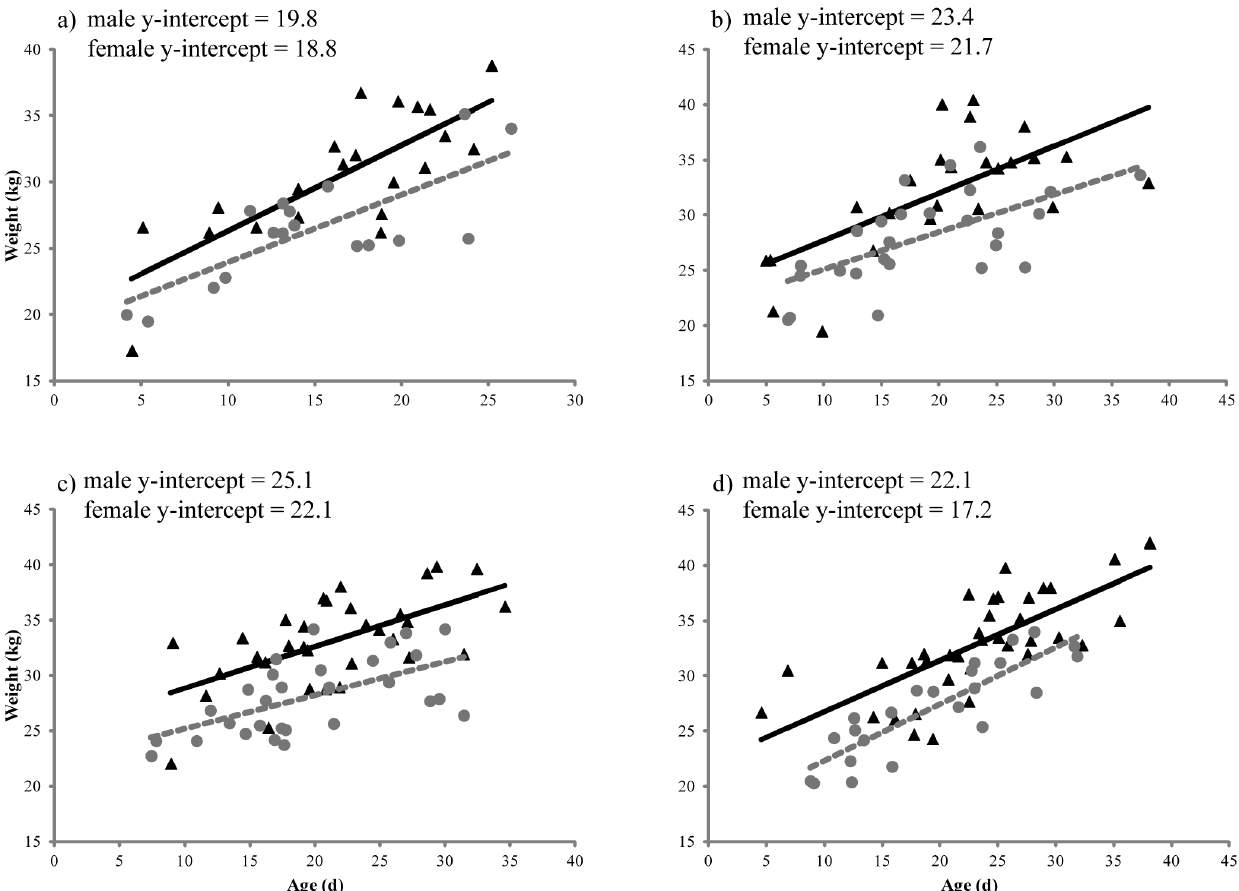
Figure 2. Regressions of mass on age for males ( m ) and females ( N ) from a) 2005, b) 2007, c) 2008, and d) 2010. Residuals for each individual were subtracted from the y-intercept by sex and year to obtain birth mass estimates. All regressions were highly significant (P , 0.001).